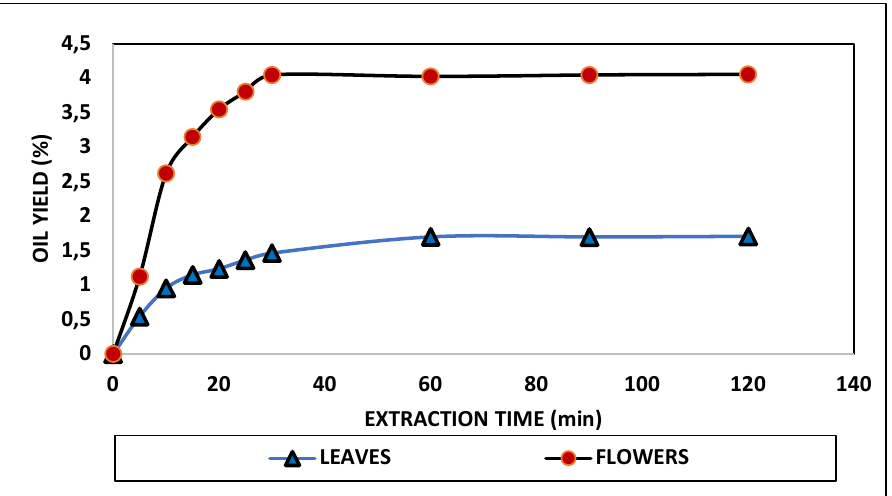
Figure 4. The effect of time extraction on M. pulegium essential oil yield operating conditions: (temperature 80 °C, time after cutting 7 days and water: material ratio 20